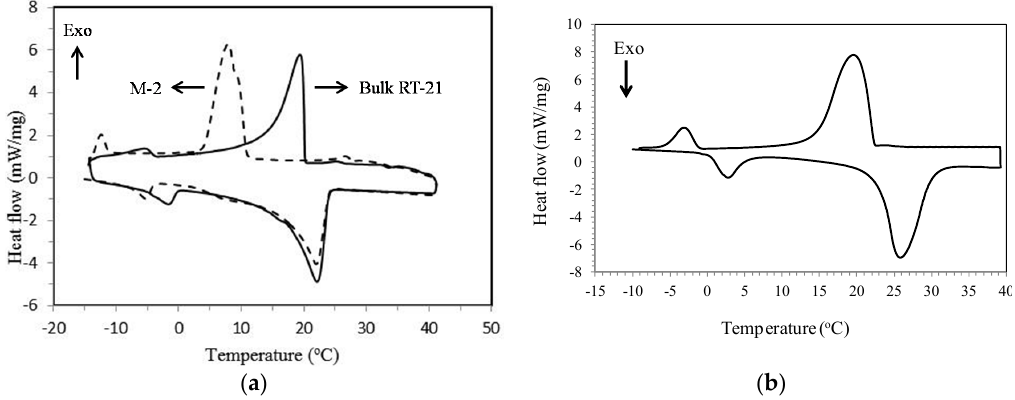
Figure 3. DSC results for: ( a ) M ‐ 2; and ( b ) Micronal ® DS 5008 X.